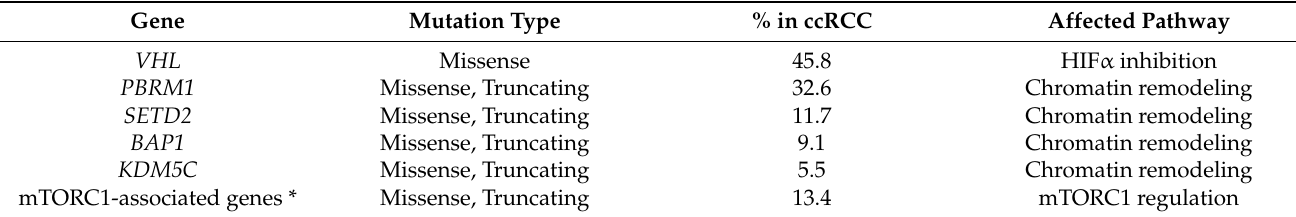
Table 2. Driver Mutations for ccRCC (Clark et al.